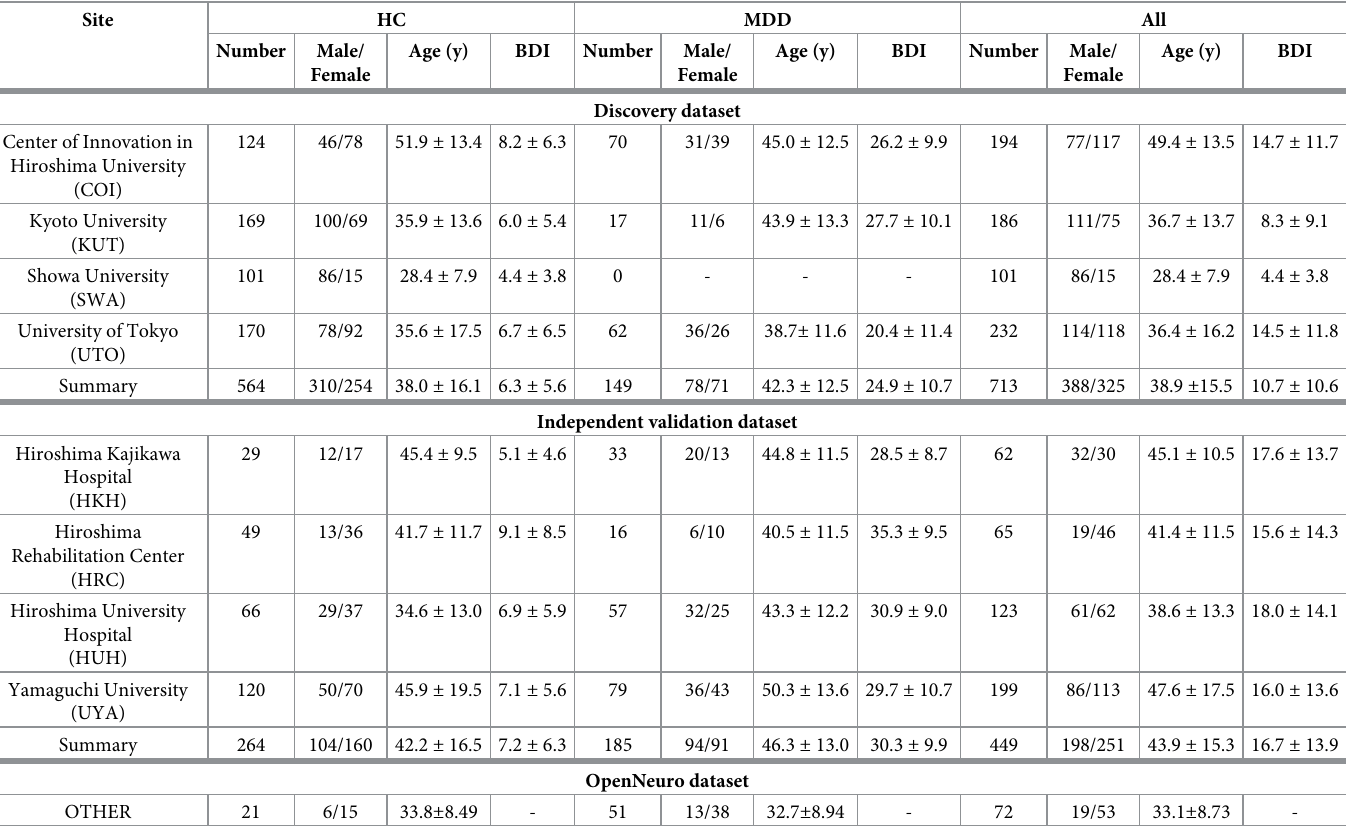
Table 1. Demographic characteristics of participants in both